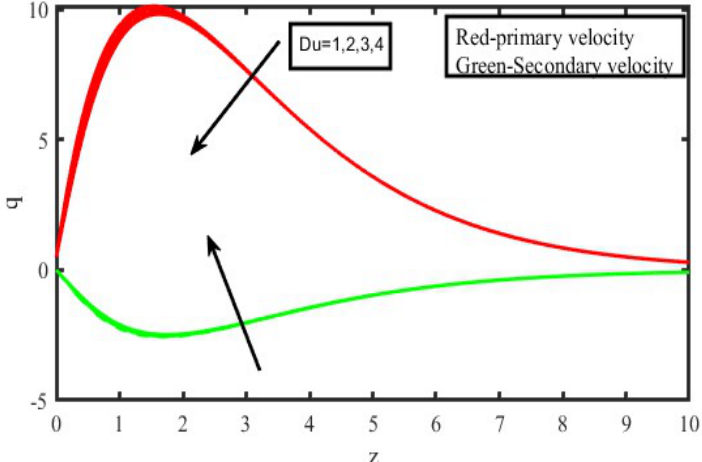
Figure 8. Velocity profiles for u and v for Diffusion thermo specification (D u ).